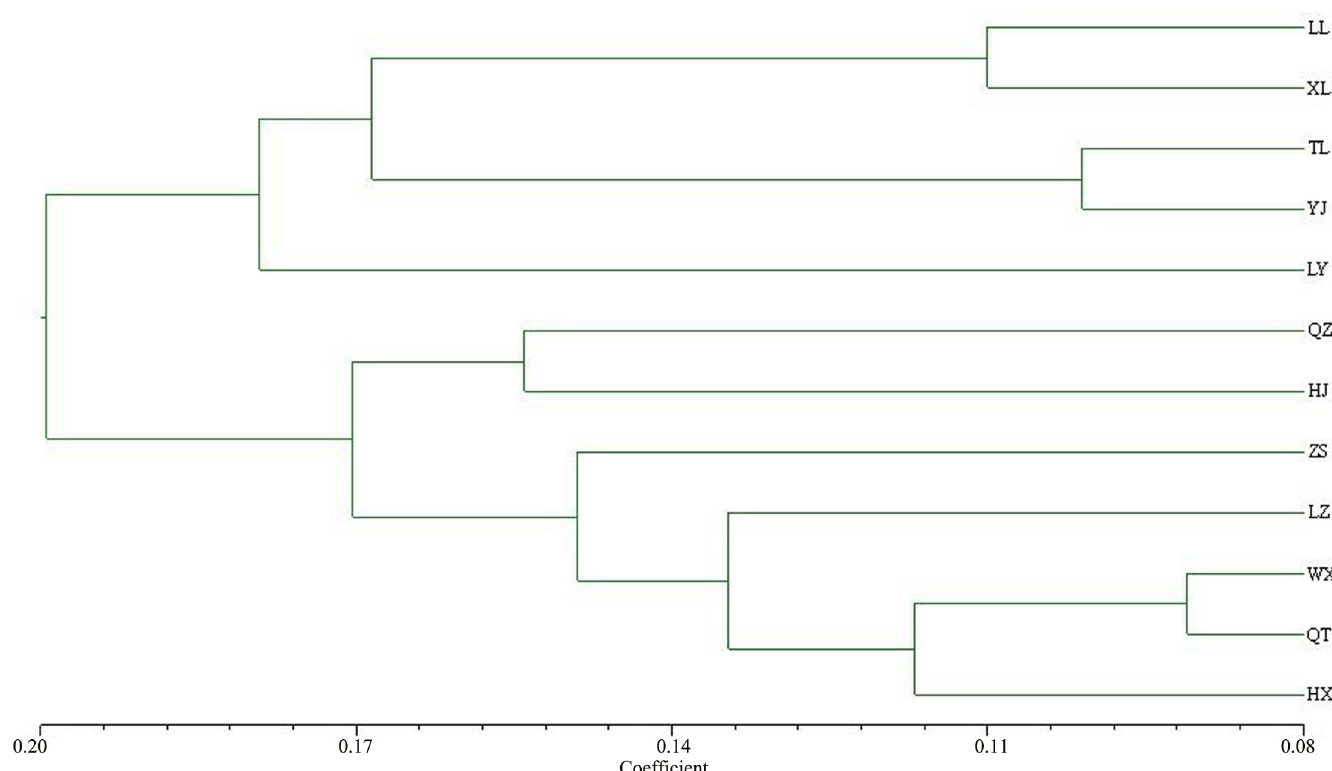
Fig 4. UPGMA dendrogram of the natural D . kaki var . silvestris Mak populations based on Nei ’ s genetic distance.